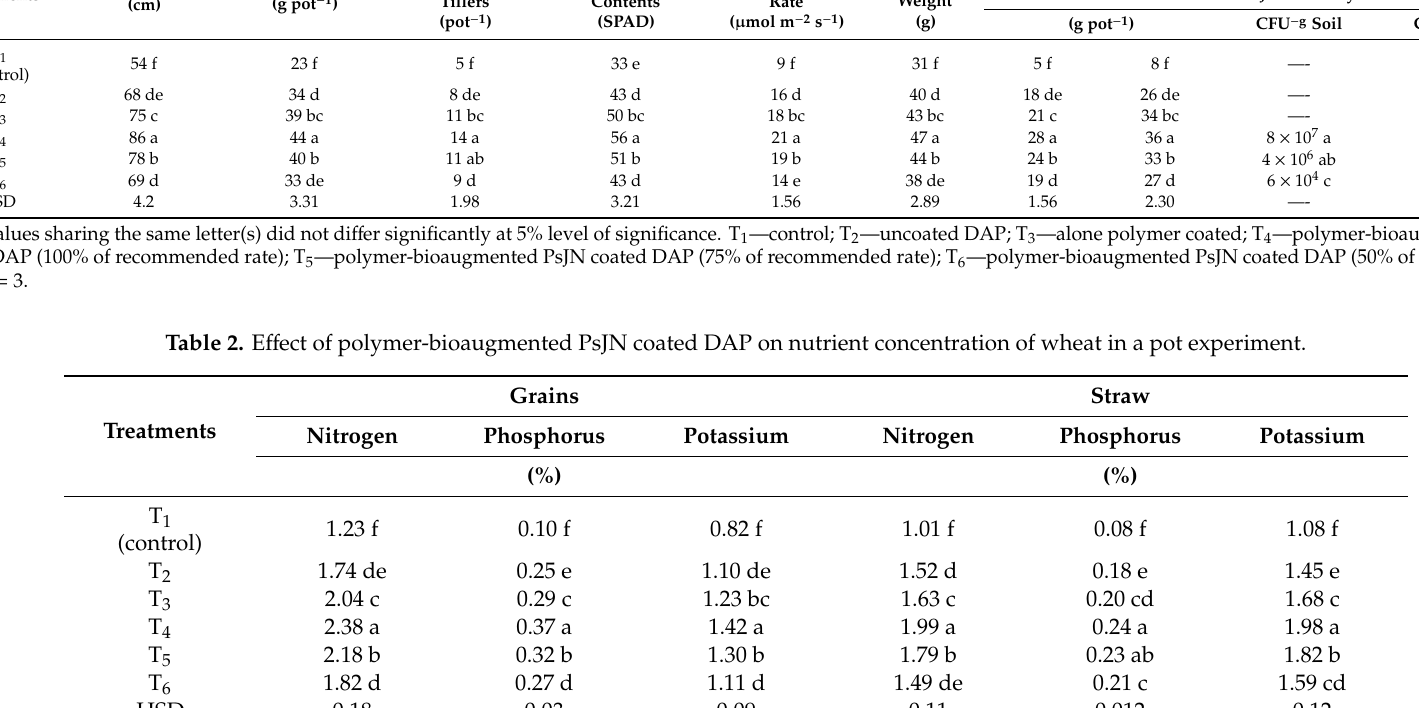
Table 1. E ff ect of polymer-bioaugmented PsJN coated DAP on yield contributing attributes of wheat and microbe delivery at the target site in a pot experiment. Treatments